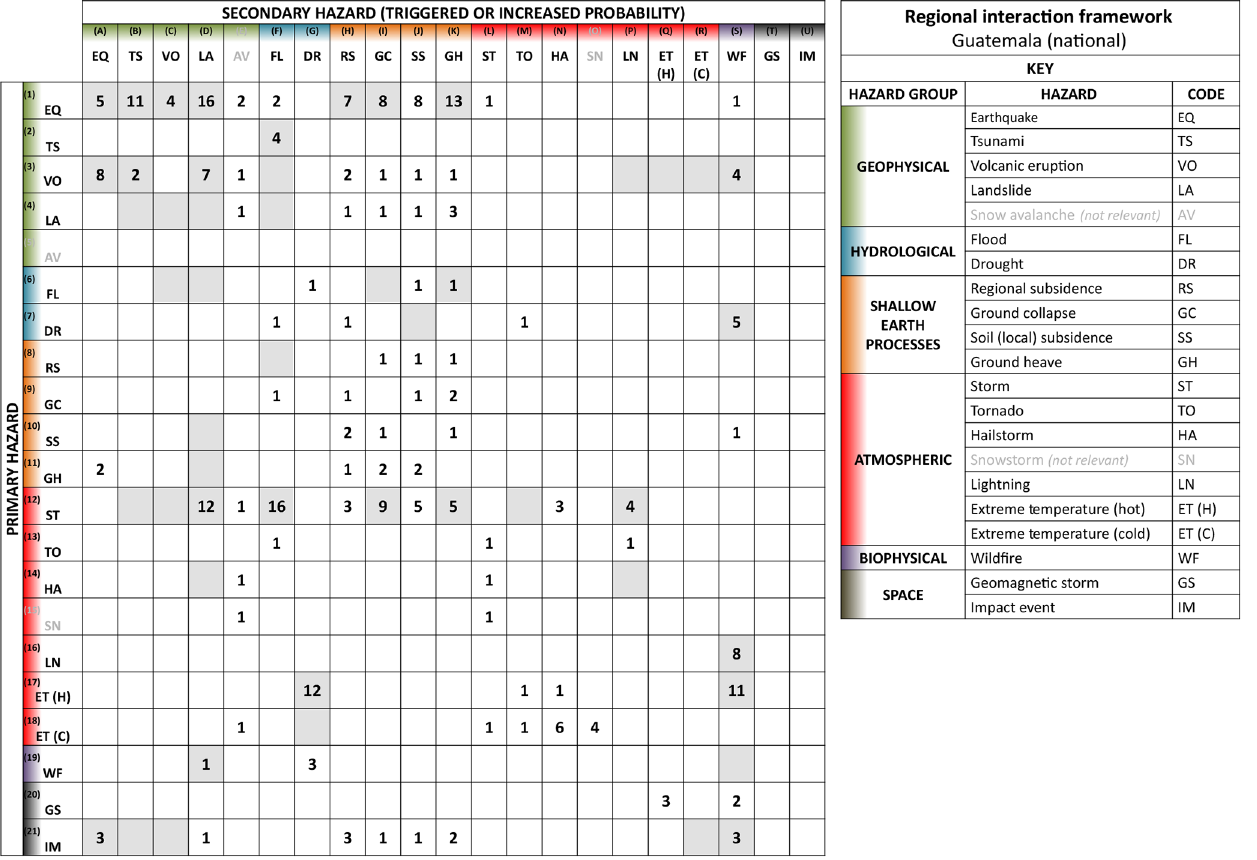
Figure 7. Stakeholder identification of possible natural-hazard interactions in Guatemala, overlain over the national interaction framework developed in Fig. 3. A 21 × 21 matrix with primary natural hazards on the vertical axis and the same natural hazards presented as secondary hazards on the horizontal axis. These hazards are coded, as explained in the key. These matrices show cases where a primary hazard could trigger and/or increase the probability of a secondary hazard. Grey cell shading indicates the interaction and was identified in the national hazard interaction matrix presented in Fig. 3. Numbers indicate the total number (from a maximum of 16) of stakeholders proposing each hazard interaction as being possible in